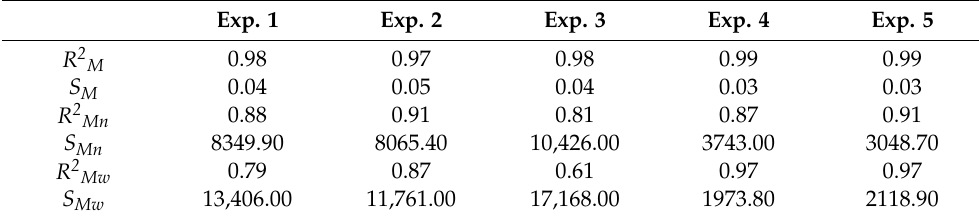
Table 3. Values of R 2 and the standard deviation (S) for the model prediction of data of [ M ], M n and M w